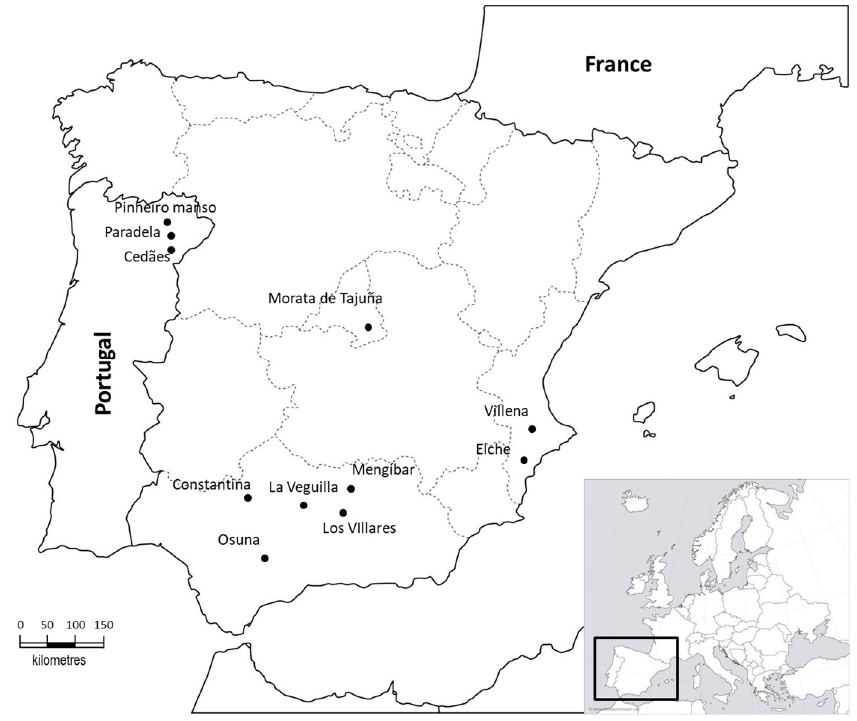
Figure 1. Sampling sites in the Iberian Peninsula.